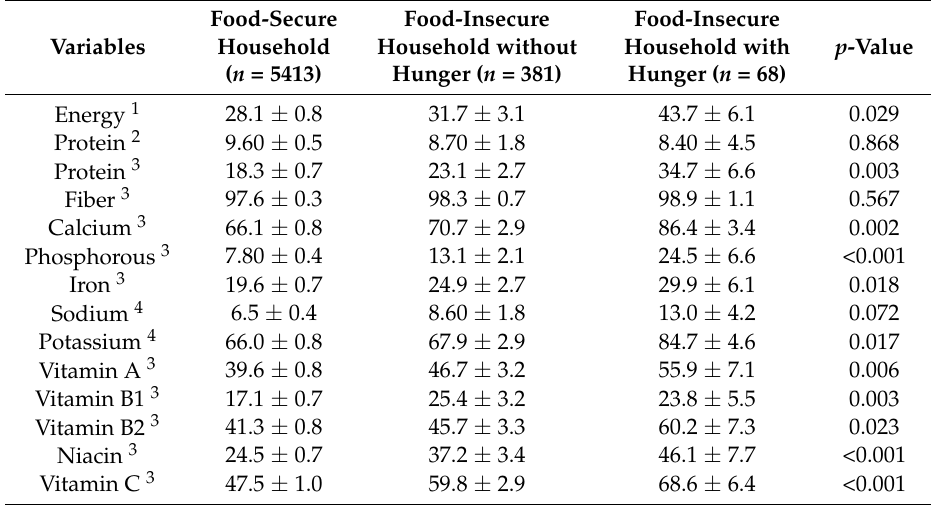
Table 2. Proportion of participants who were energy and nutrient deficient when compared with the 2015 Korean Dietary Reference Intakes (KDRIs) per household food security